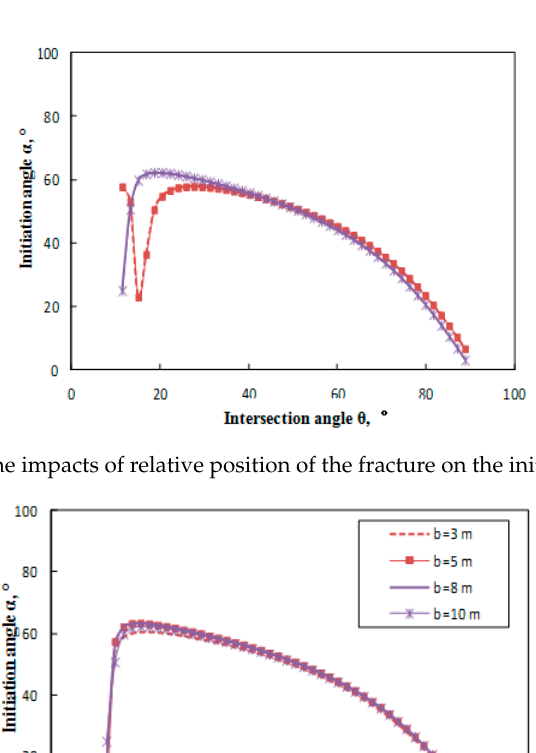
Figure 8. The impacts of distance of the fracture on the initiation angle.